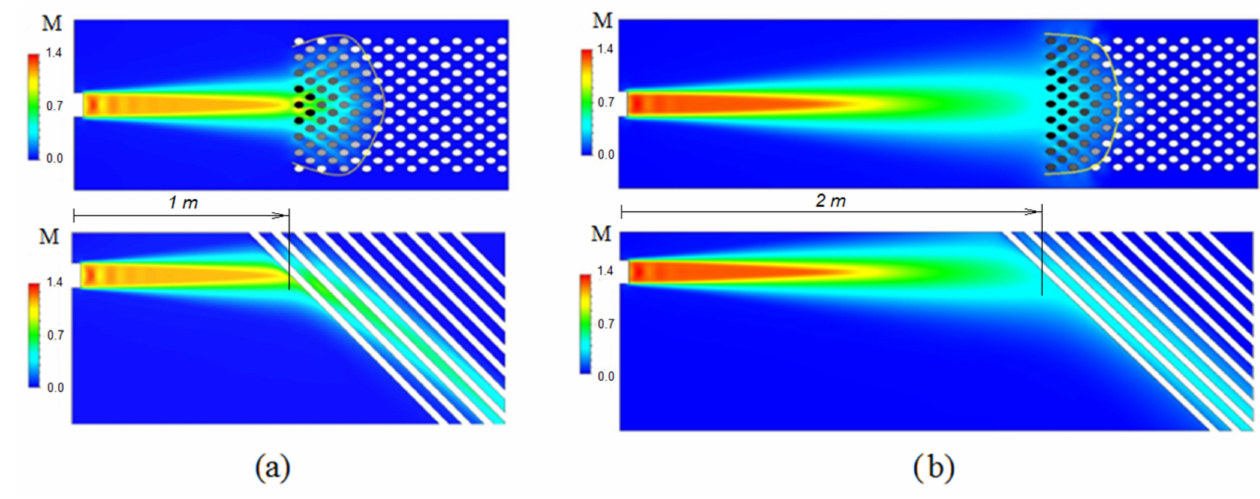
Figure 6. Blowing of the tube package by an air jet with pressure P 0 = 0.235 MPa. ( a ) Case 3; and ( b ) case 7. Upper—XOY plane, lower—XOZ plane.